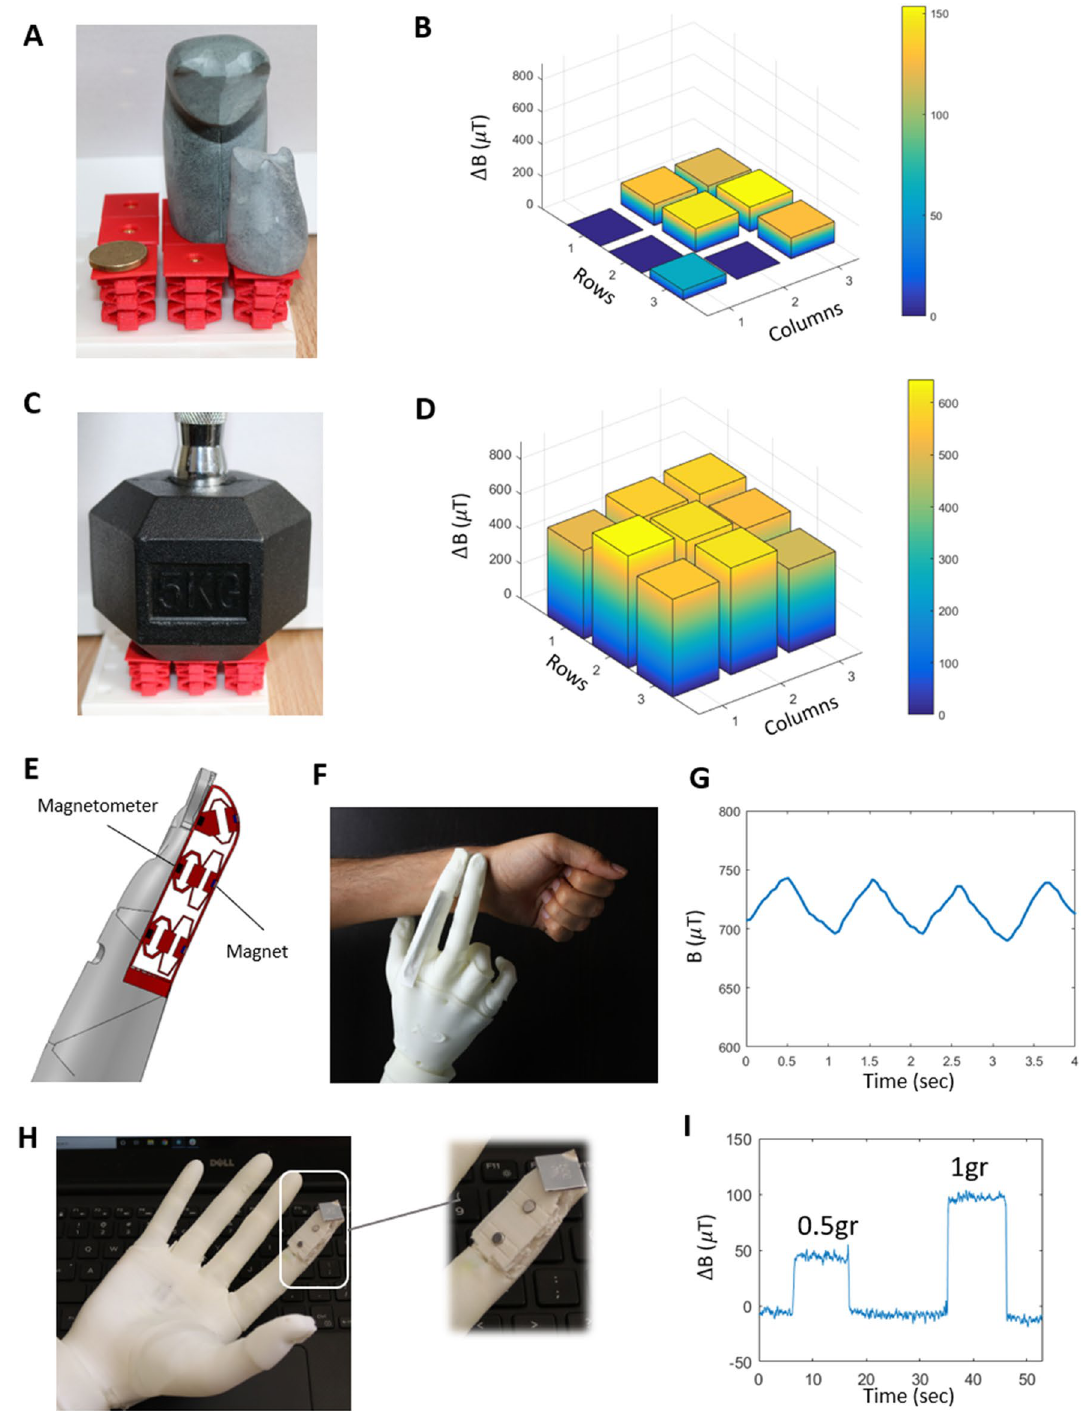
Figure 4. Performance demonstration of two example designs of the MST sensor. ( A ) A 3 × 3 array of three- layer blocks with three objects on them: a $2 Australian coin (6.6gr), a handicraft stone kitten (56gr), and cat (265gr). ( B ) Results of the MST sensor reading of the coin and handicraft stone kitten and cat. ( C ) A 5 kg dumbbell on the MST sensor array. ( D ) Results of the sensor reading of the 5 kg dumbbell. ( E ) The schematic of the robotic prosthetic finger with integrated MST sensor. ( F ) 3D printed robotic prosthetic hand with embedded MST sensor in its index finger for monitoring the pulse of human radial artery. ( G ) The magnetic field variation of the middle block of the MST sensor due to the pulse wave. ( H ) The robotic hand with integrated MST sensor for detecting small contact forces. ( I ) The response of the highly sensitive unit cell at the tip of the finger to different